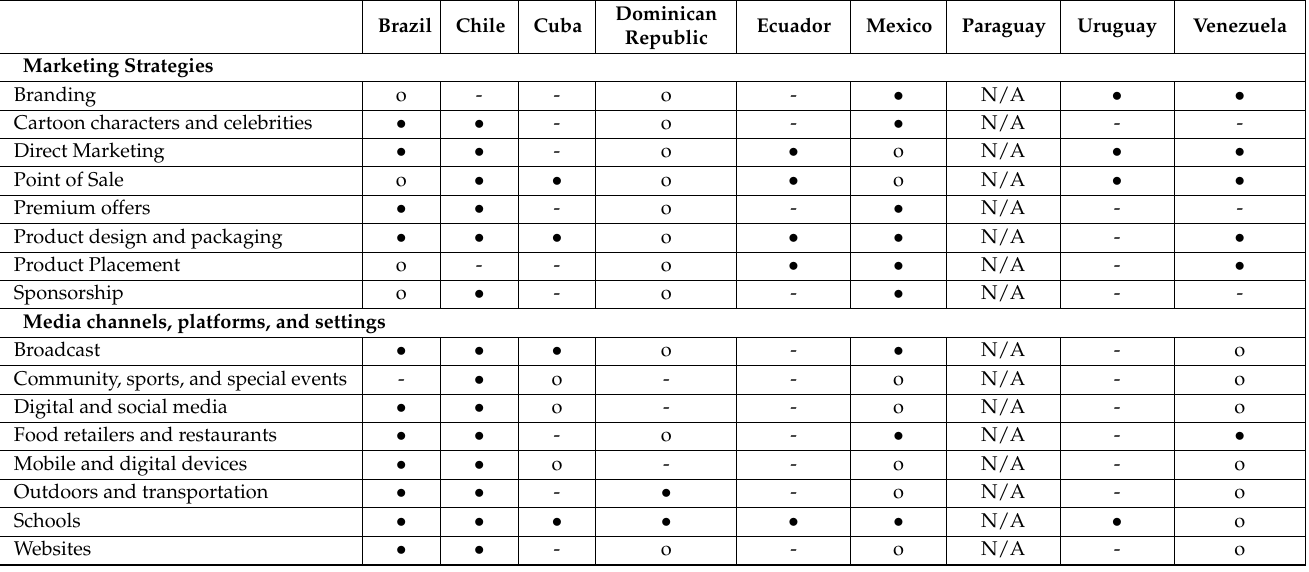
Table 3. Marketing strategies, channels, platforms and settings covered in countries in the region of the Americas that have enacted policies, strategies or actions to restrict the marketing of HFSS food and non-alcoholic beverages.